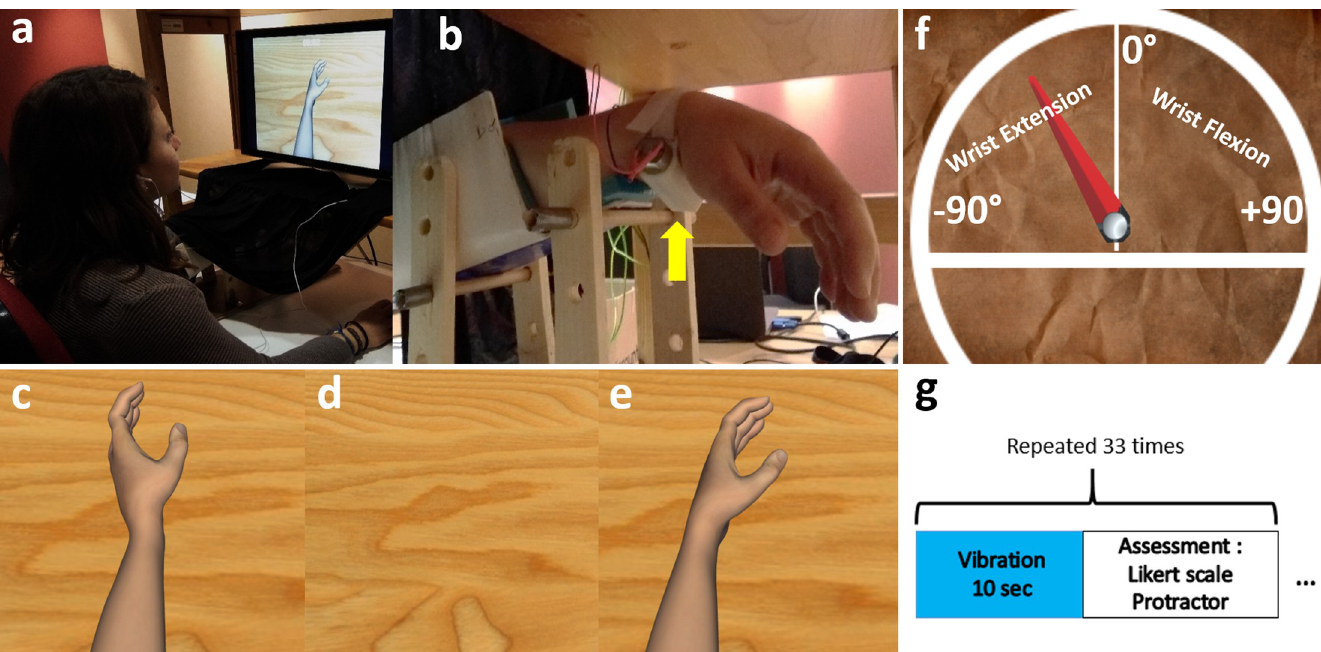
Fig 1. Apparatus used in the experiment (exemple for a right-handed participant). a-b) Set-up of the vibrator. A black curtain covered the forearm of the participant. c-d-e) Visualization of the three virtual visual conditions (respectively Moving, Hidden, Static condition). A black arrow (not visible during the experiment) indicates the movement of the wrist in the Moving condition, from flexion to extension. f) Measure of sensation of displacement with the protractor. « -90˚ » indicates an extreme wrist extension in the case of a left upper limb. The notes «values of degree» and « wrist extension, wrist flexion » are not visible by the participant during the